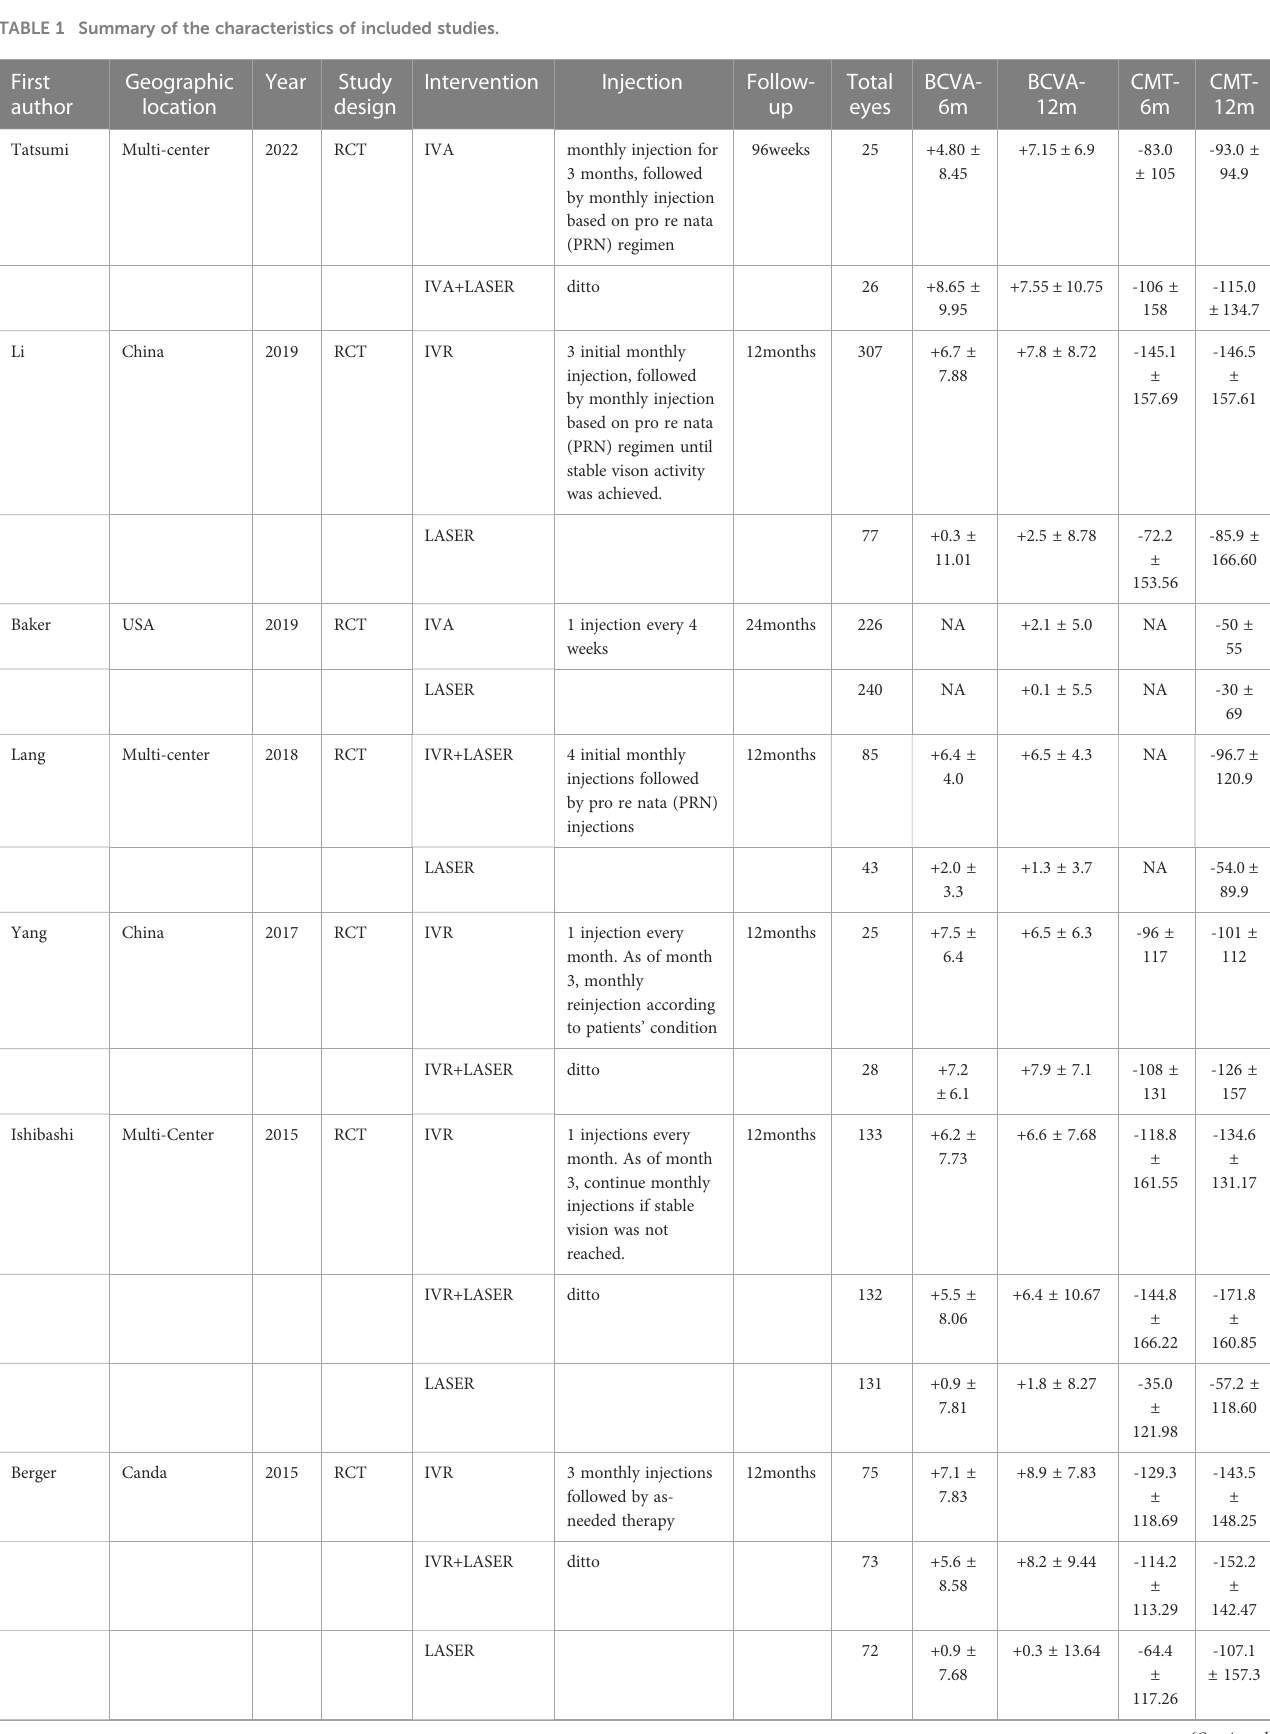
TABLE 1 Summary of the characteristics of included